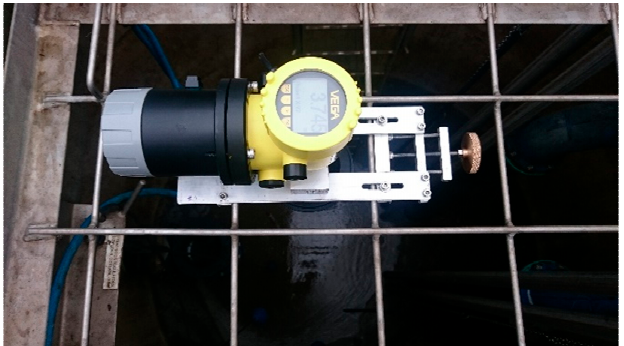
Figure 8. SPUDD adjustable mounting bracket.